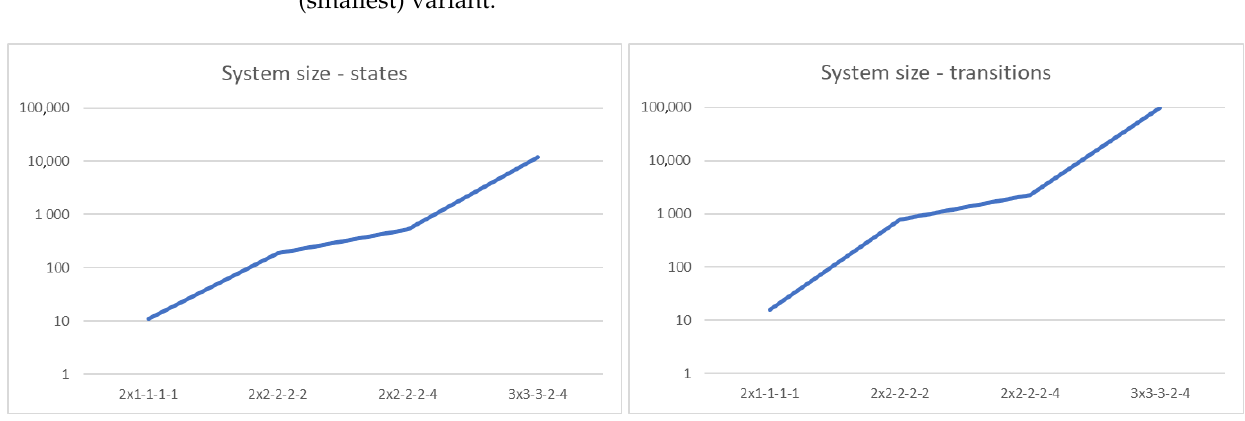
Figure 15. Size of scenario 2 system for all its